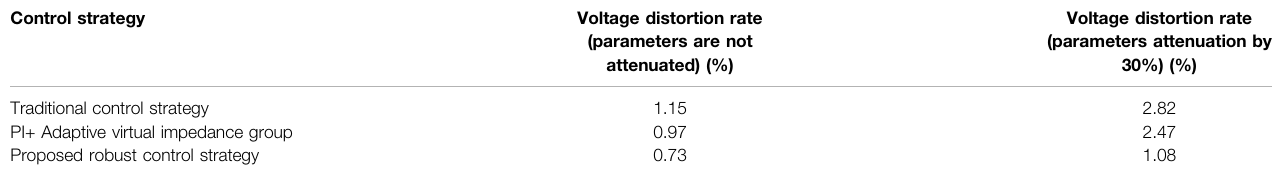
TABLE 4 | Parametric perturbation analysis. Control strategy Voltage distortion rate